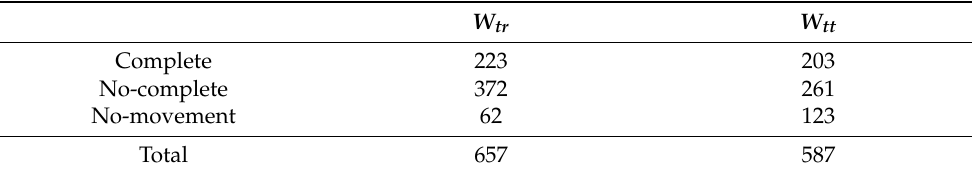
Figure 5. The waveforms of the fitness movements were used for classification. Table 8. The distribution of training and testing data in database W